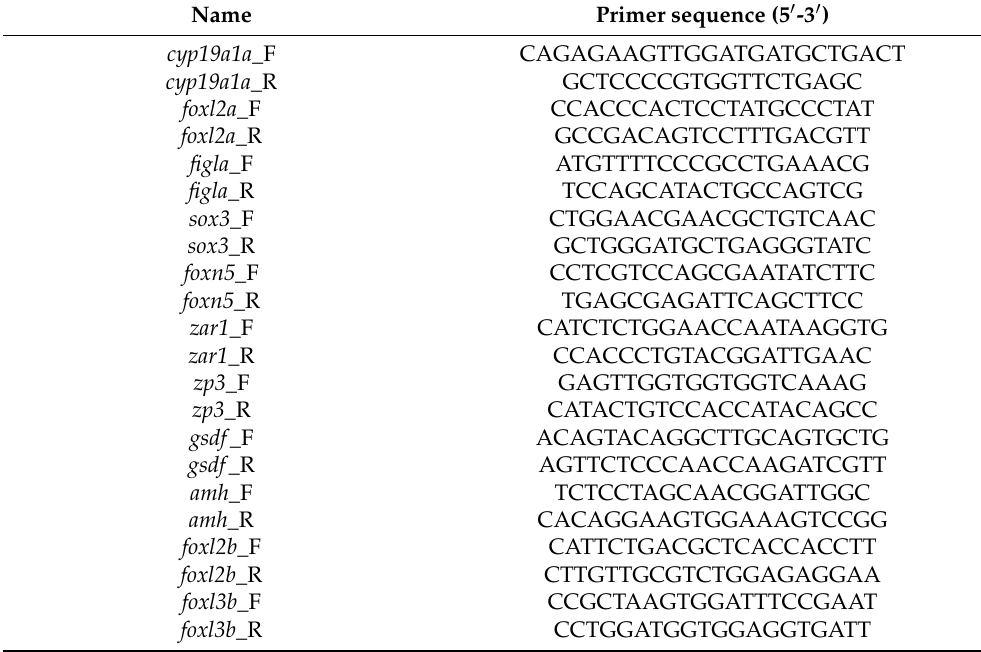
Table 1. Primer sequences of sex differentiation-related genes used to